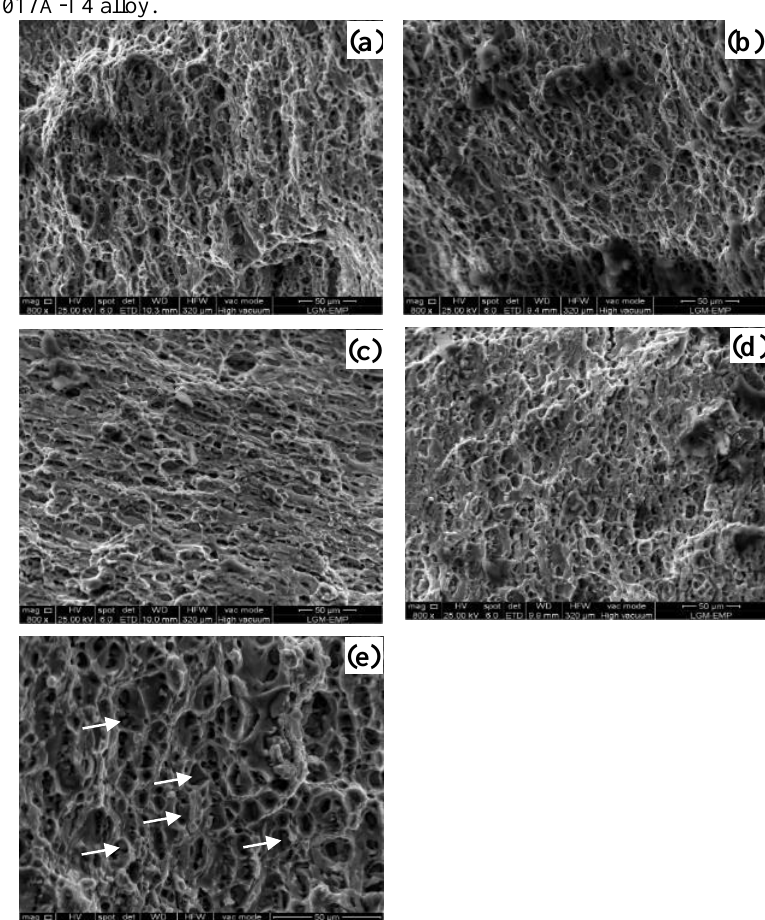
Fig. 8. SEM micrographs of the fracture surface of the 2017A-T4 alloy under aging treatment at 170 °C for: (a): 5 h, (b): 10 h, (c): 15 h, (d): 20 h, and (e): 30